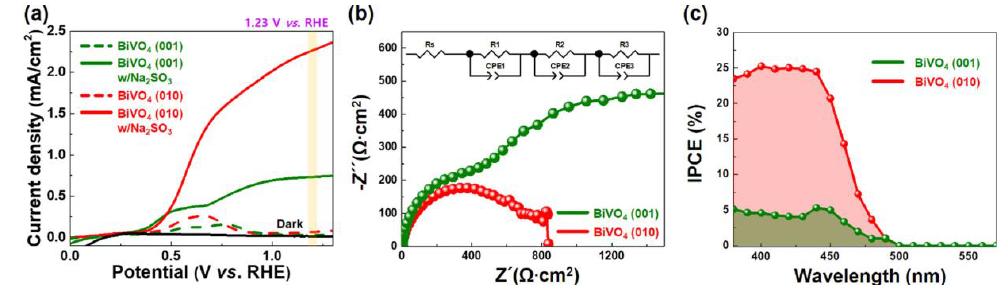
Figure 6. ( a ) PEC performances of 100 nm-thick epitaxial BiVO 4 films with different crystallographic orientations. The electrolyte of 0.5 M Na 2 SO 4 aqueous solutions in the presence or absence of 0.5 M Na 2 SO 3 was used for the measurement. ( b ) EIS spectra and ( c ) IPCE of the BiVO 4 with different crystallographic orientations. Inset of ( b ) shows the equivalent circuit for the data. Reprinted with permission from [19]. Copyright 2018, American Chemical Society.